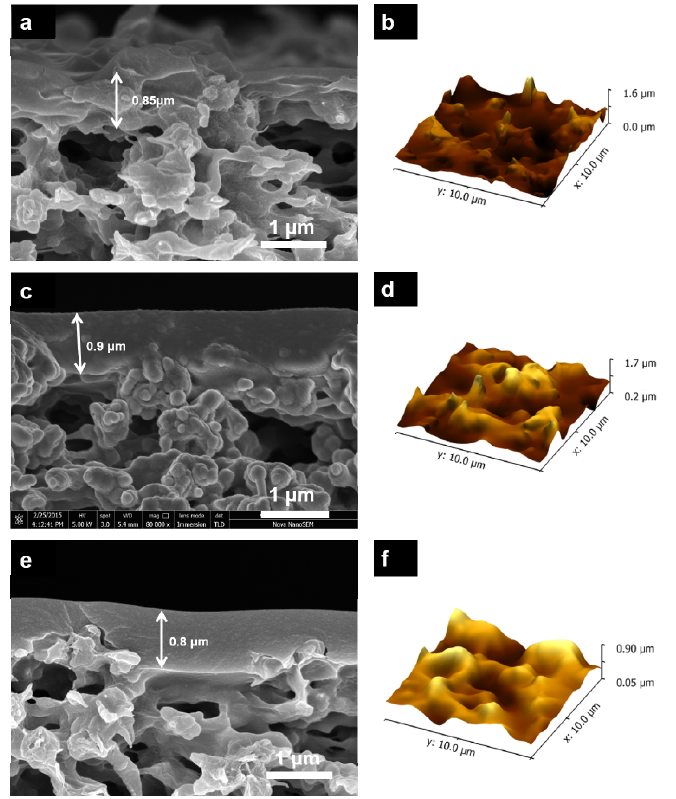
Figure 4. Cross ‐ sectional SEM and AFM surface height images of PVA/PVDF composite membrane Figure 4. Cross-sectional SEM and AFM surface height images of PVA/PVDF composite membrane with MR of ( a ) and ( b ) 0.025, ( c ) and ( d ) 0.1, ( e ) and ( f ) 0.2. with MR of ( a ) and ( b ) 0.025; ( c ) and ( d ) 0.1; ( e ) and ( f ) 0.2. Table 2. Characterization results of composite PVA/PVDF membrane (Diffusivity of NaCl in pure